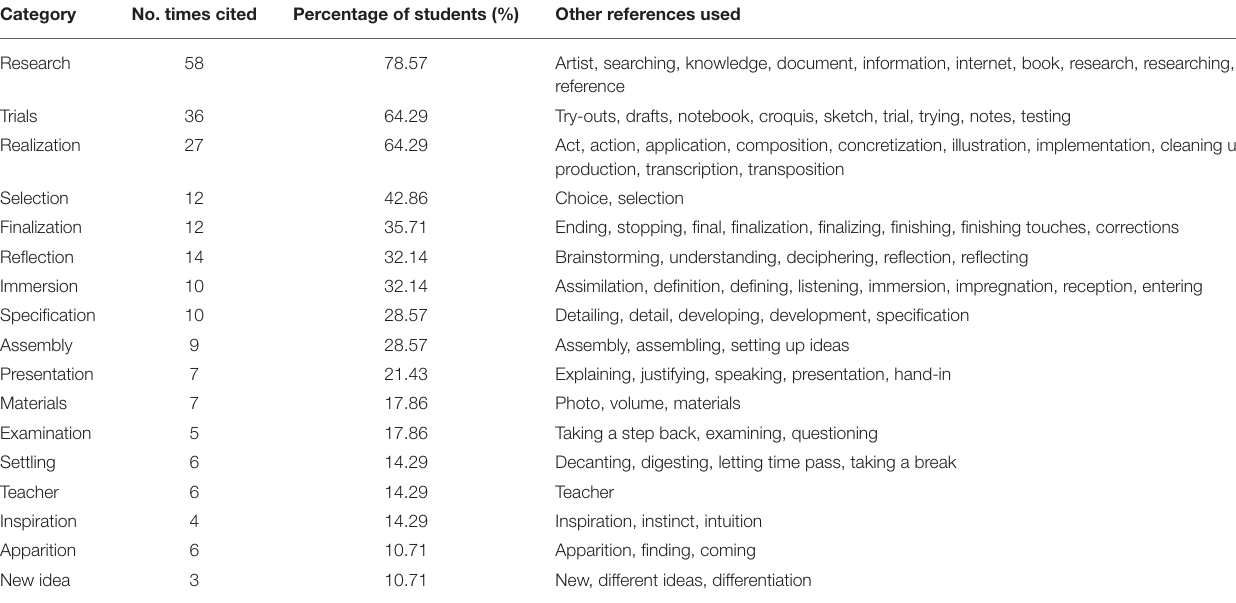
TABLE 3 | Categories used in naming the stages of the creative